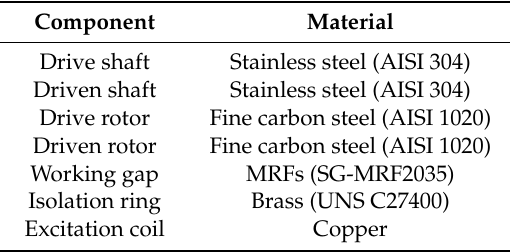
Table 2. Materials for main components of the